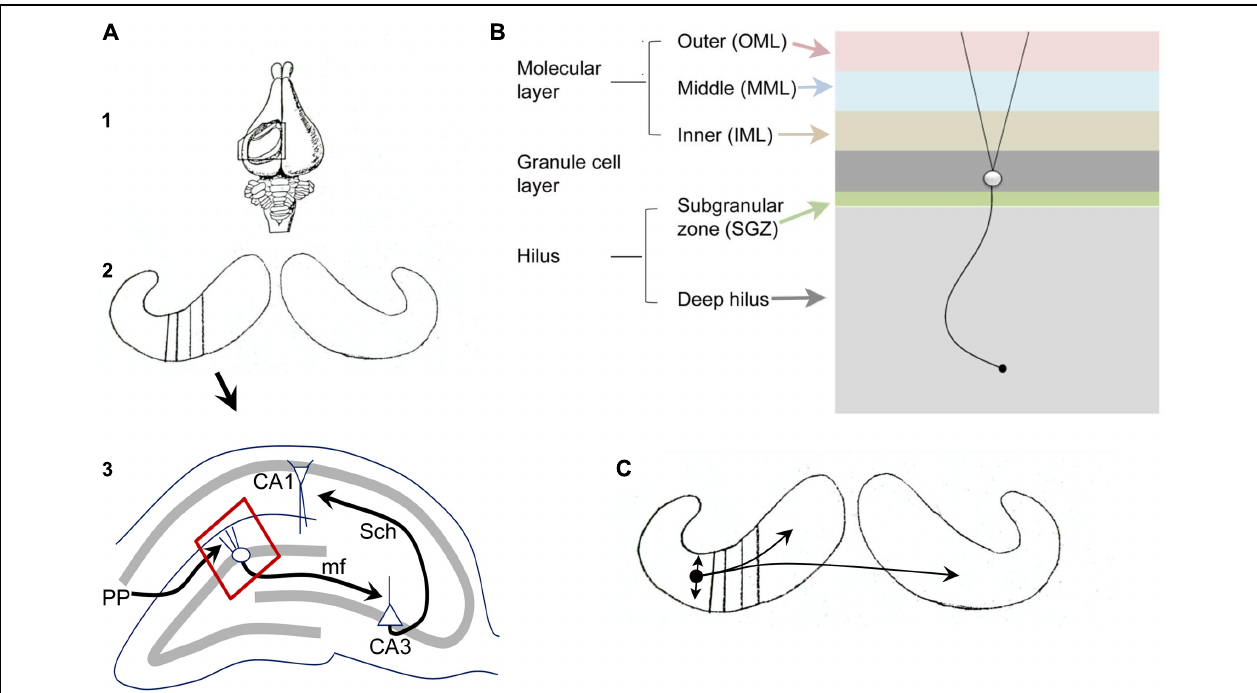
FIGURE 1 | Fundamental organization of the DG. (A) (1) A dorsal view of the rabbit brain with the cortex over the hippocampus removed to show the underlying hippocampus. From Andersen et al. (1971). (2) Both hippocampi are shown, with black lines indicating the transverse (lamellar) axis. (3) A single lamella is illustrated to show the trisynaptic circuit. PP, perforant path axons of entorhinal cortical neurons from layer II; mf, mossy fiber axons of granule cells; Sch, Schaffer collateral axons of CA3